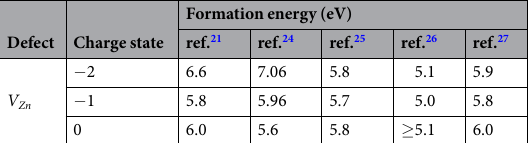
Table 5. Calculated formation enthalpies for V Zn defects in bulk zinc oxide for zinc-rich and p -type conducting conditions [E F = 0 eV, VBM]. ref. 21 ; DFT, LDA, ultra-soft pseudopotentials; ref. 24 : GGA + U; ref. 25 : DFT, LDA, norm-conserving pseudopotentials; ref. 26 : DFT, GGA, ultra-soft pseudopotentials; and ref. 27 : DFT, LDA, norm- conserving pseudopotentials.